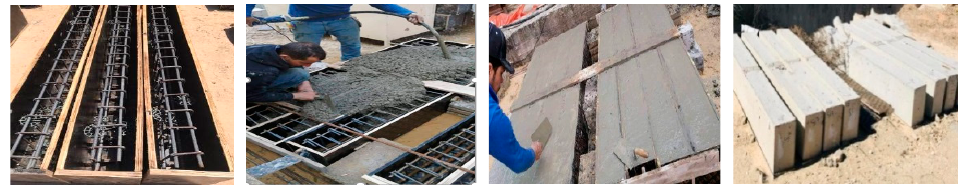
Figure 3. Beam Casting and